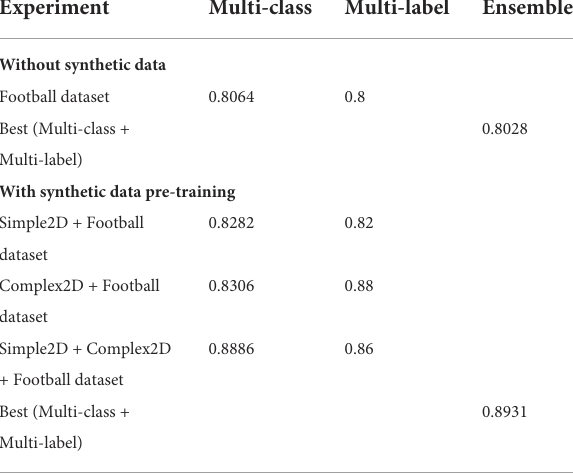
TABLE 2 A comparison of model performance under different conditions with confidence threshold of 0.5.